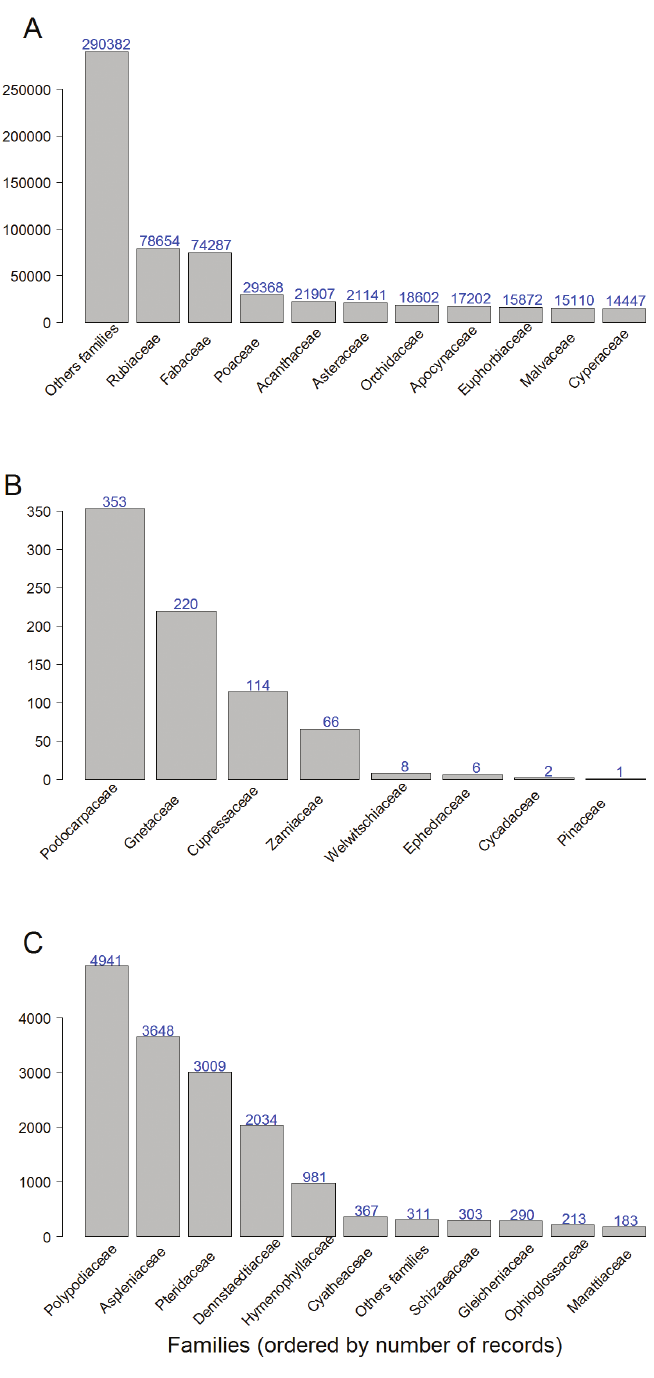
Figure 3. Most represented families (sorted by number of records) for each of the three divisions of vas- cular plants represented in the RAINBIO database. A Magnoliophyta B Gymnosperms C